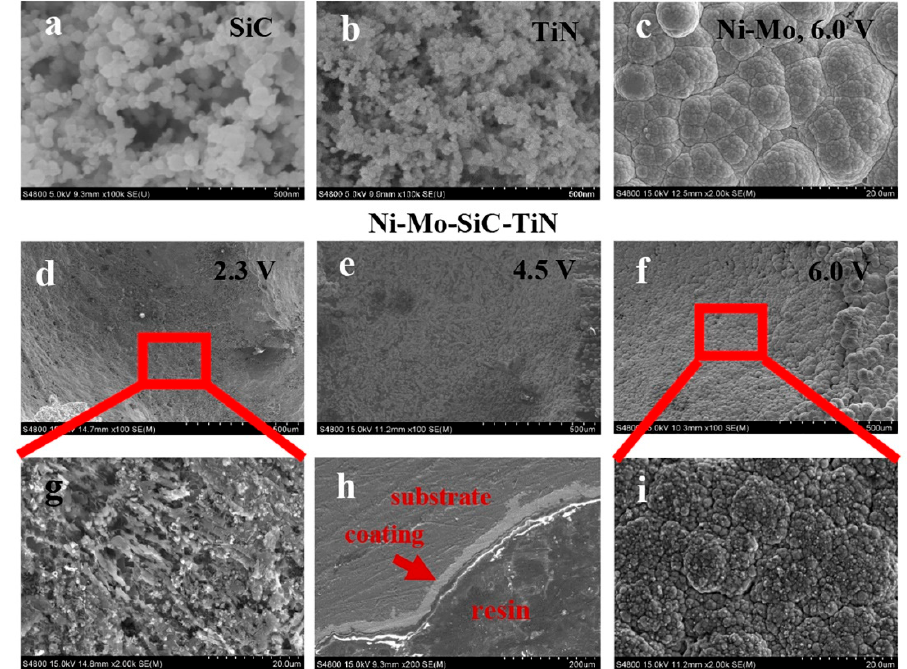
Figure 2. SEM (scanning electron microscope) images of ( a ) SiC nanoparticles, ( b ) TiN nanoparticles, ( c ) the Ni–Mo coating, and the duplex nanoparticles reinforced Ni–Mo coating electrodeposited ( d ) at 2.3 V, ( e ) 4.5 V, and ( f ) 6.0 V. The enlarged SEM images of the duplex nanoparticles reinforced Ni–